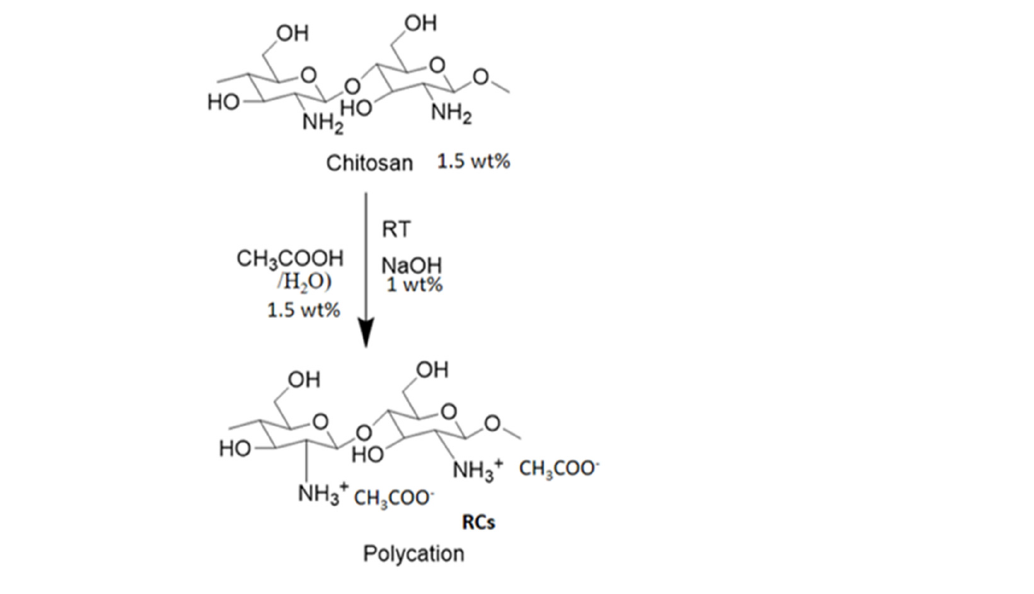
Figure 4. Chemical reaction pathway for synthesis of regenerated chitosan.